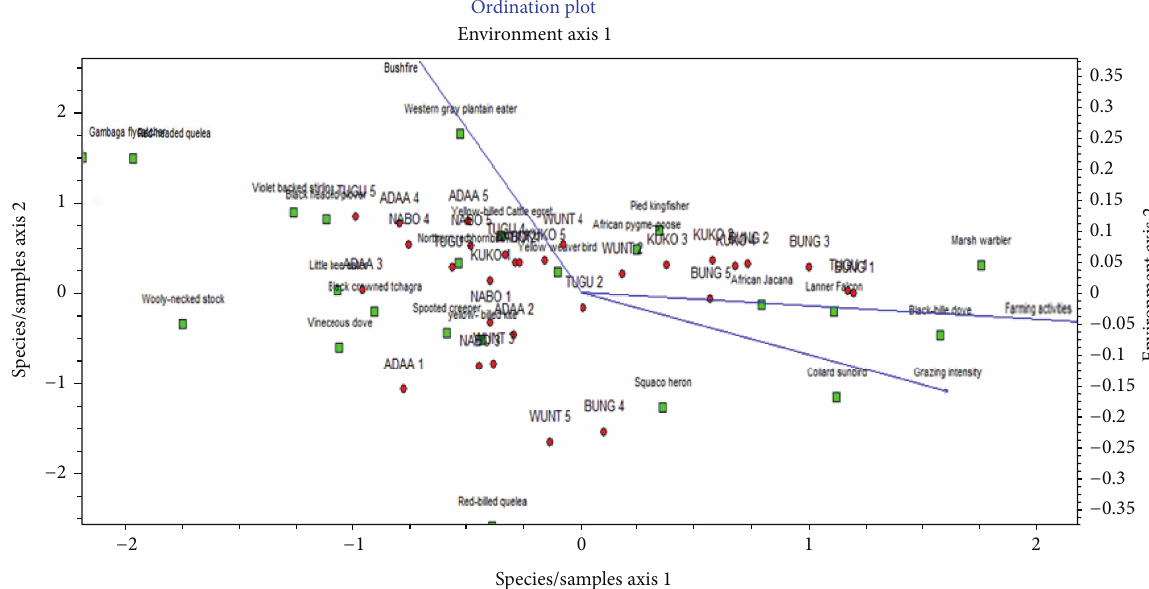
Figure 7: Canonical correspondence analysis (CCA) ordination diagram showing the relationship between environmental factors and bird assemblage in the six wetlands in the dry season. Diagram description is the same as in Figure